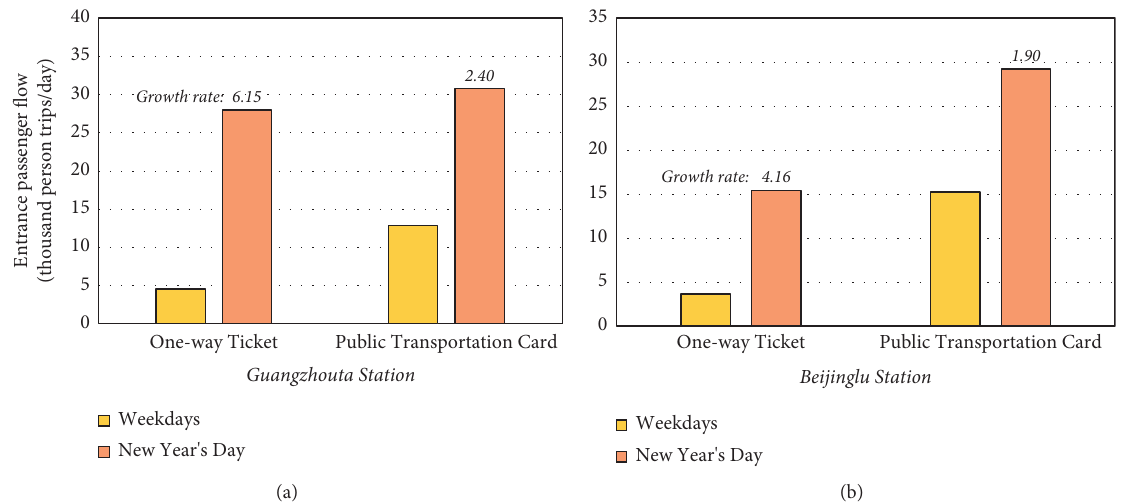
Figure 3: Comparison of passenger flow between one-way ticket and public transportation card in 2016. (a) Guangzhouta station. (b) Beijinglu